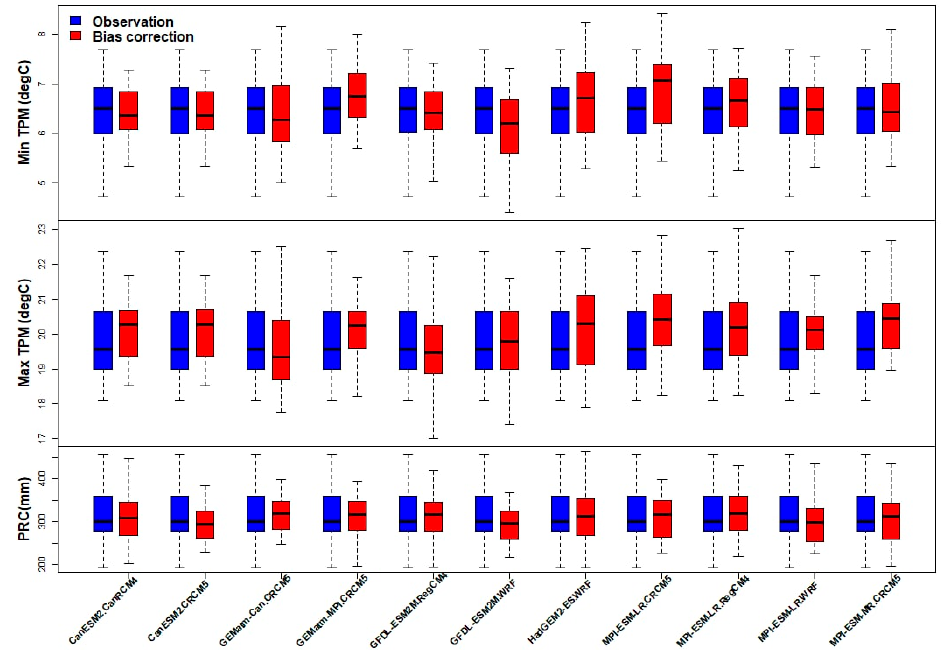
Figure 4. Box-whisker plots of the precipitation and minimum and maximum temperature derived from the observed and RCMs data.